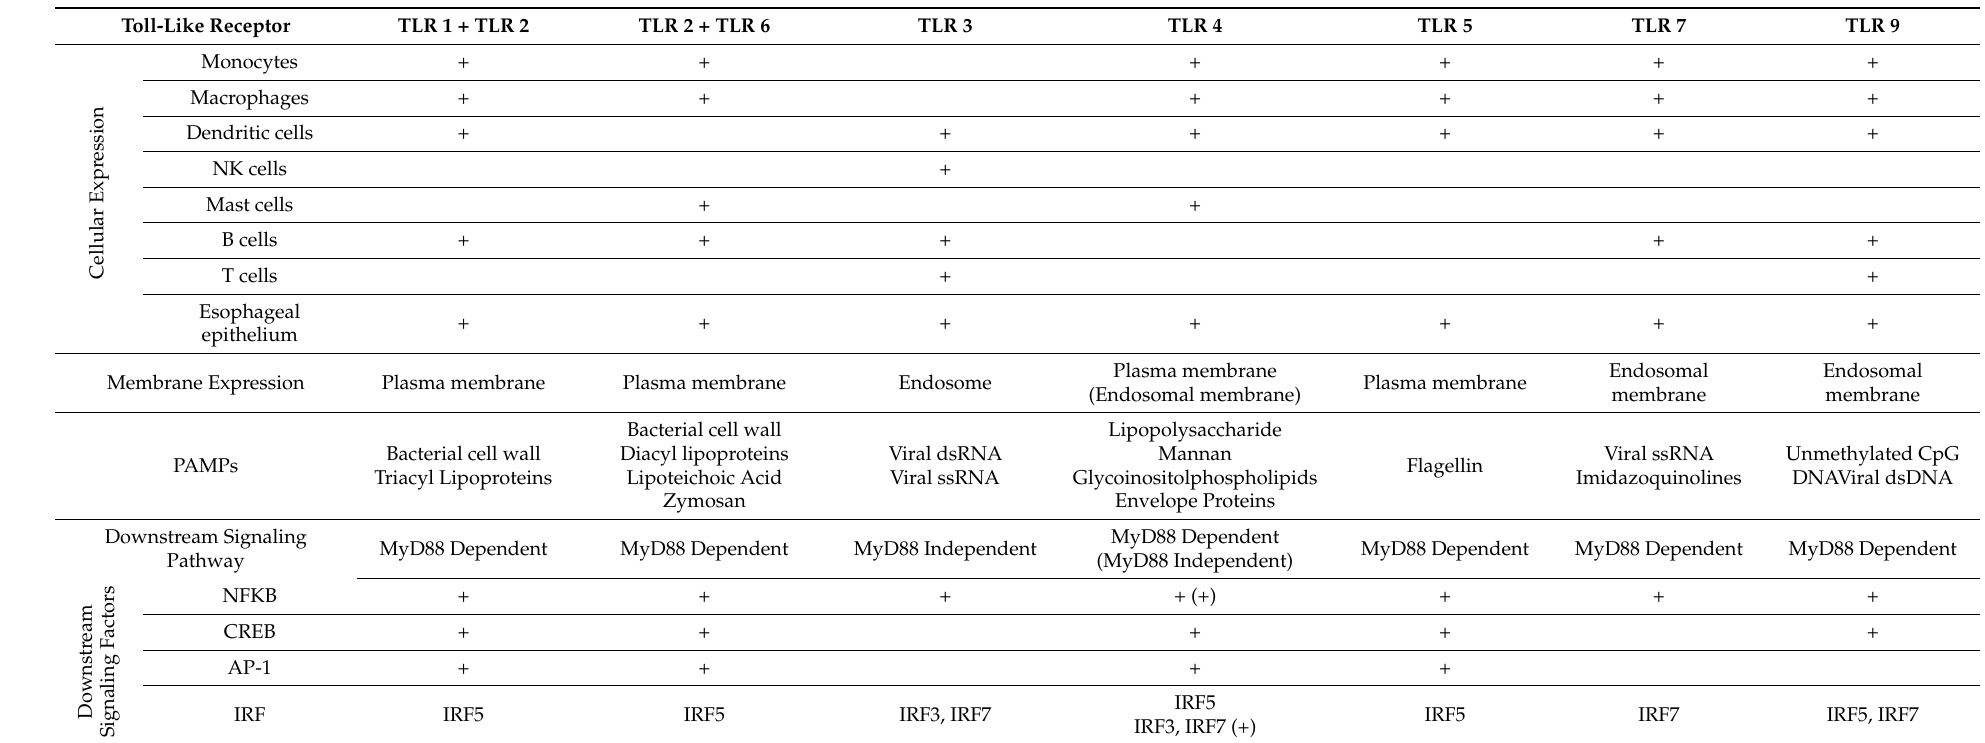
Table 3. Toll-like receptor characteristics